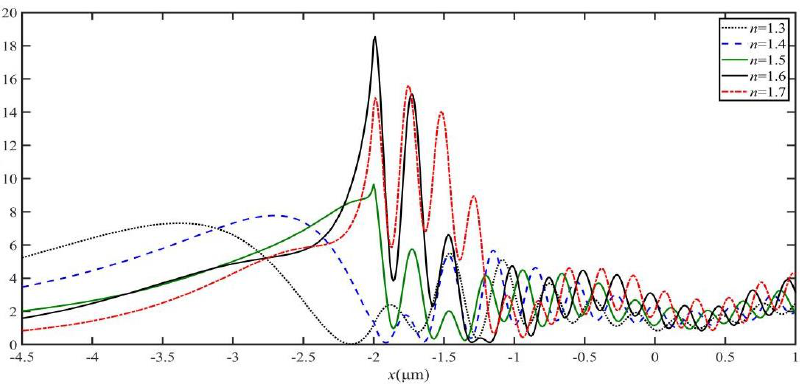
Figure 4. Optical intensity distributions of the SPP-PNJ along the y-axis with different dielectric microdisk refractive indices n .